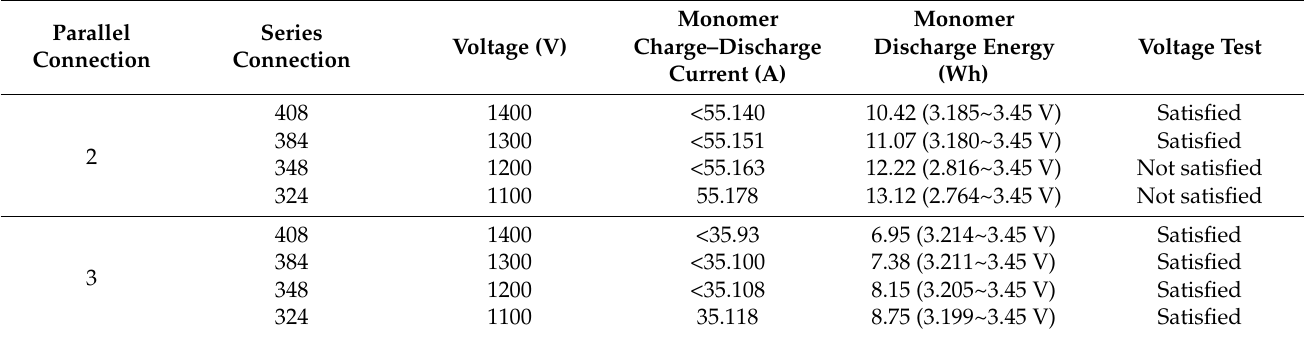
Table 7. The battery capacitor configuration